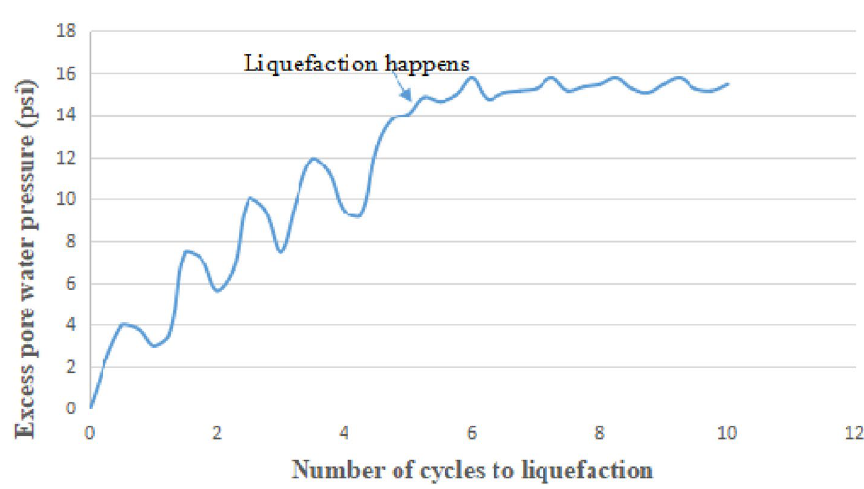
Figure 9. Pore water pressure change versus number of cycles to liquefaction in